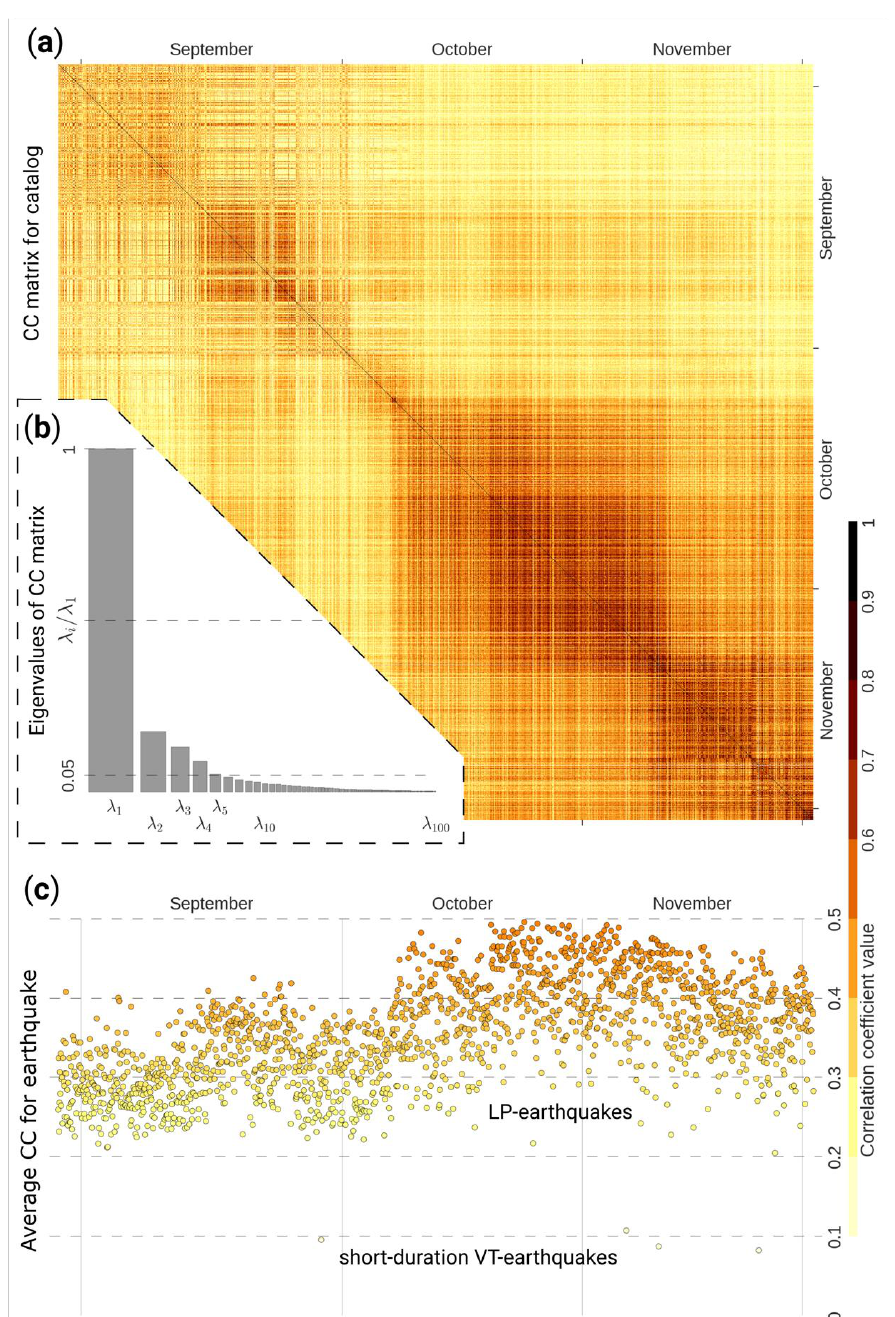
Figure 7. Similarity assessment of earthquakes from the BP based catalog: ( a ) waveform CC matrix; ( b ) first 100 eigenvalues of the matrix—sorted and normalized; ( c ) mean average similarity for each earthquake inside the catalog.